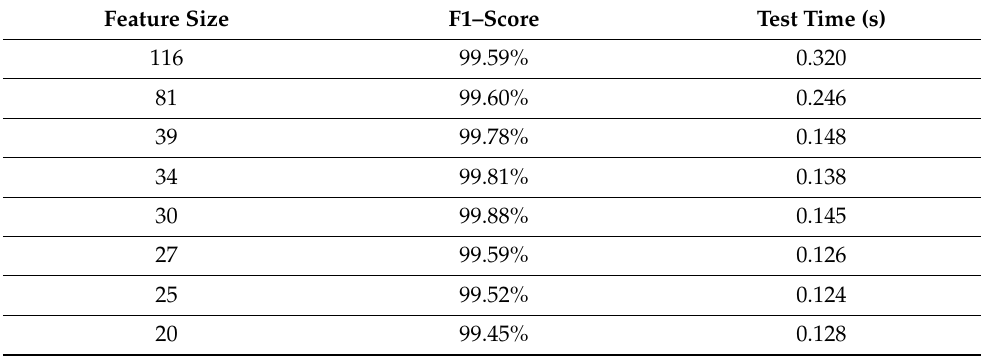
Table 11. Comparison of F1-score and test time for integrated feature-based DT, according to the size of features selected by feature